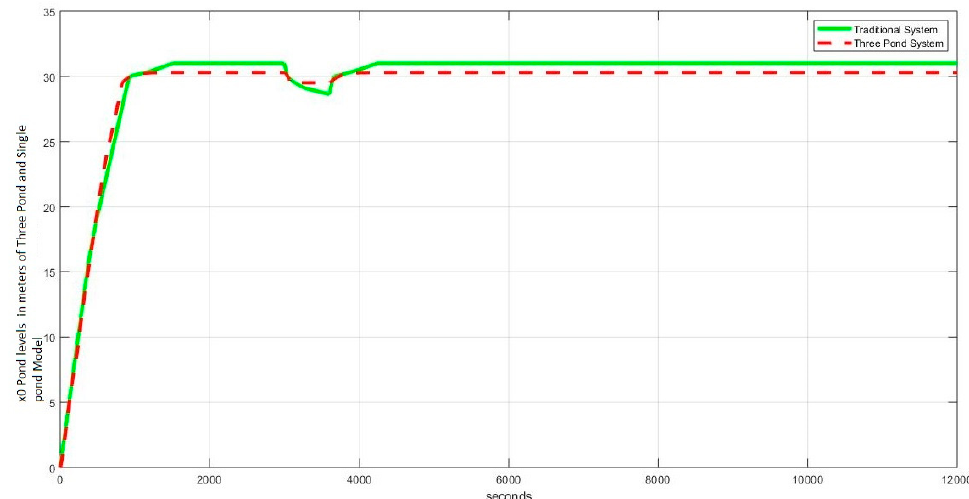
Figure 35. Comparison between traditional system and the proposed system (half) (negative surge).